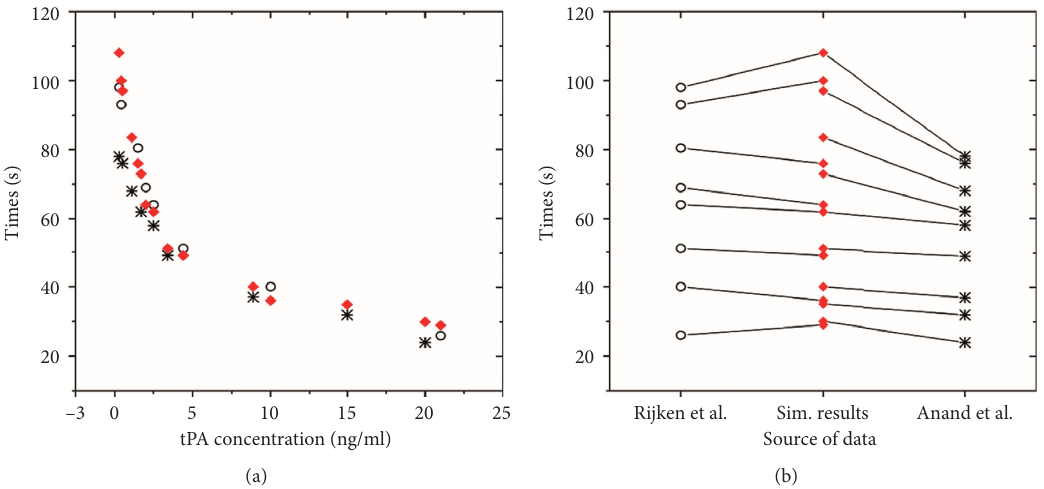
Figure 4: (a) The lytic time of simulation results and previous experiments with the condition of 95% thrombolysis. (b) The comparison of simulation results with experimental results, and low deviation explores high similarity.